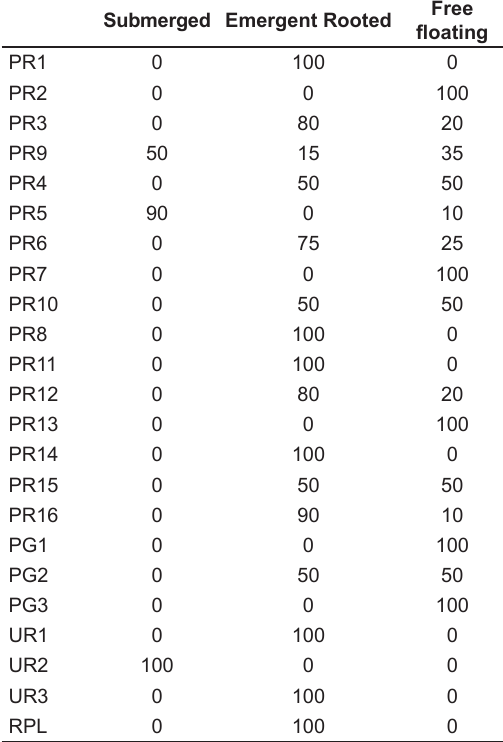
Table 2. Coverage percentage of the main types of macrophytes in each sampling site during summer. Estimations based on in situ observation and standardized photo sequences